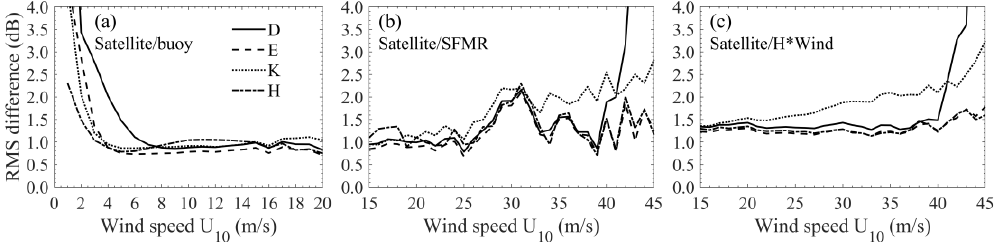
Figure 4. RMS differences between the predictions of the PO model with D (solid curve), E (dashed curve),